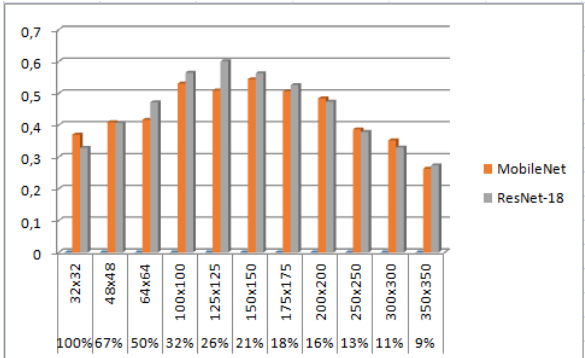
Figure 7. Classification of test images for the KHATT dataset using both Resnet-18 and MobileNet models with several original patche sizes